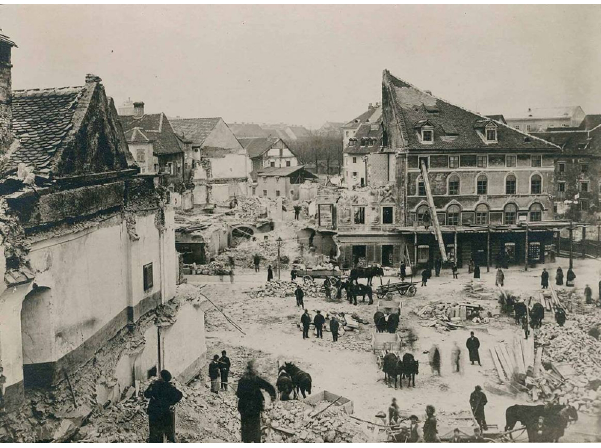
Figure 3. Earthquake damage in Ljubljana 1895 (TSN, 2020).